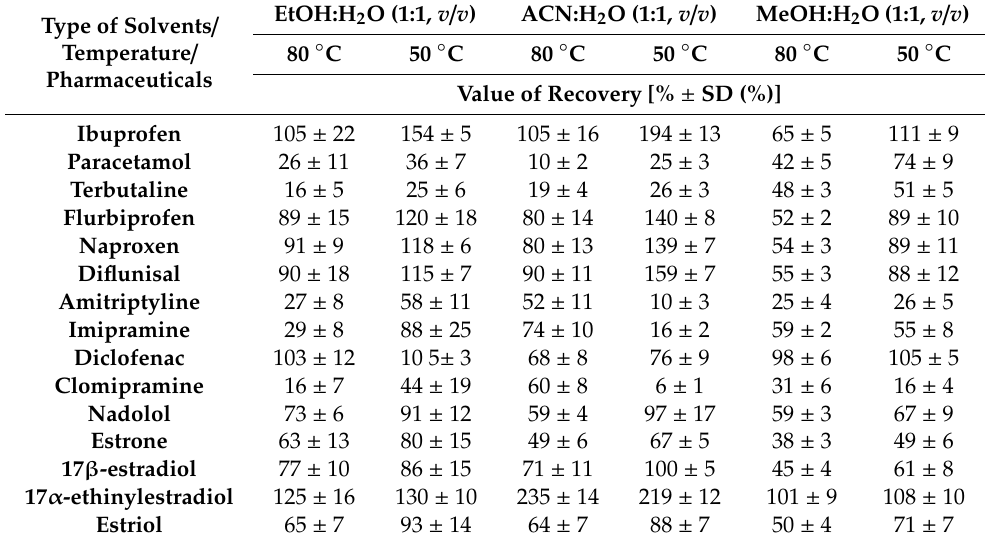
Table 2. Recoveries (mean ± SD) of fifteen analytes using di ff erent conditions of the ASE procedure ( n = 3, conc. 1000 ng / g d.w.).